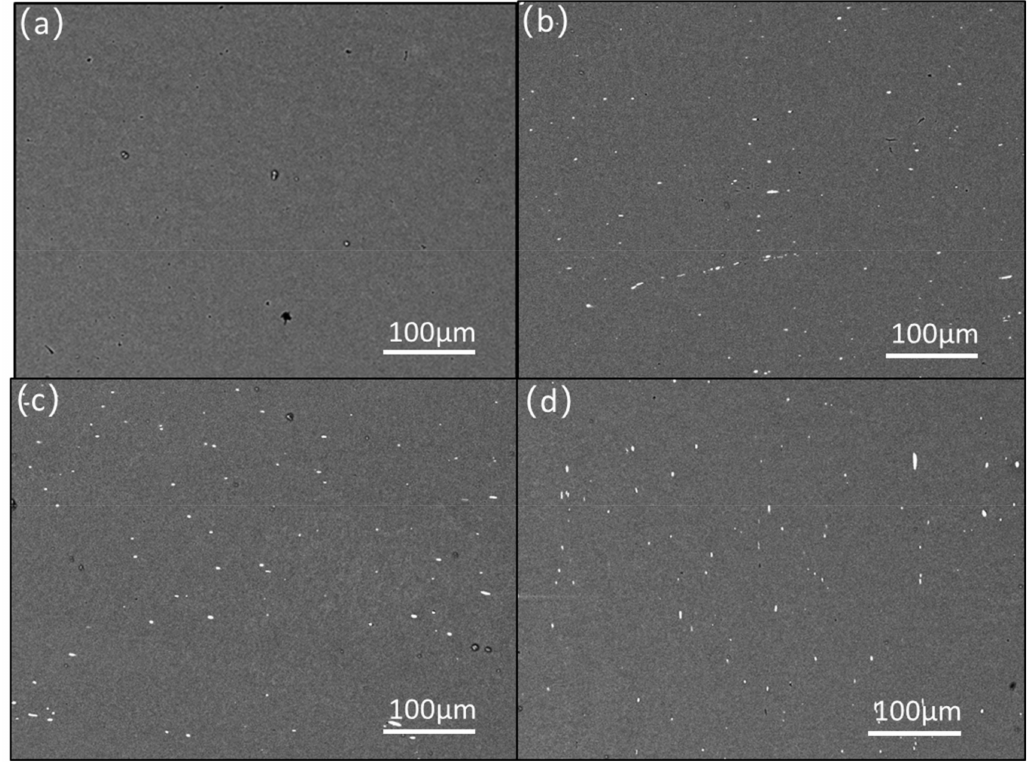
Figure 3. Backscattered electron (BSE) images of Al-Mg-Sn-Ga-xBi alloys. ( a ) Al-Mg-Sn-Ga, ( b ) Al- Mg-Sn-Ga-0.08Bi, ( c ) Al-Mg-Sn-Ga-0.10Bi, ( d )